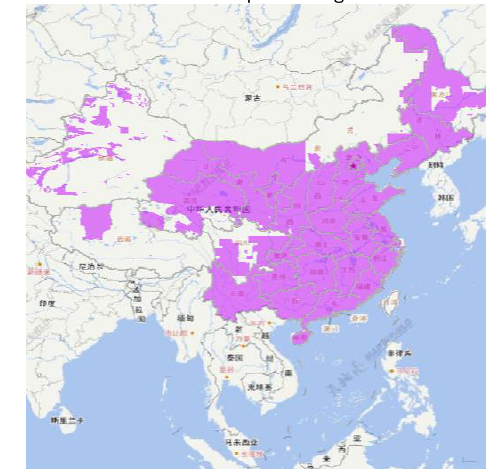
Figure 7. Browse map on one screen